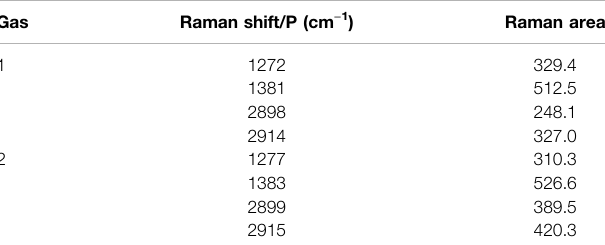
TABLE 2 | The information provided by Raman